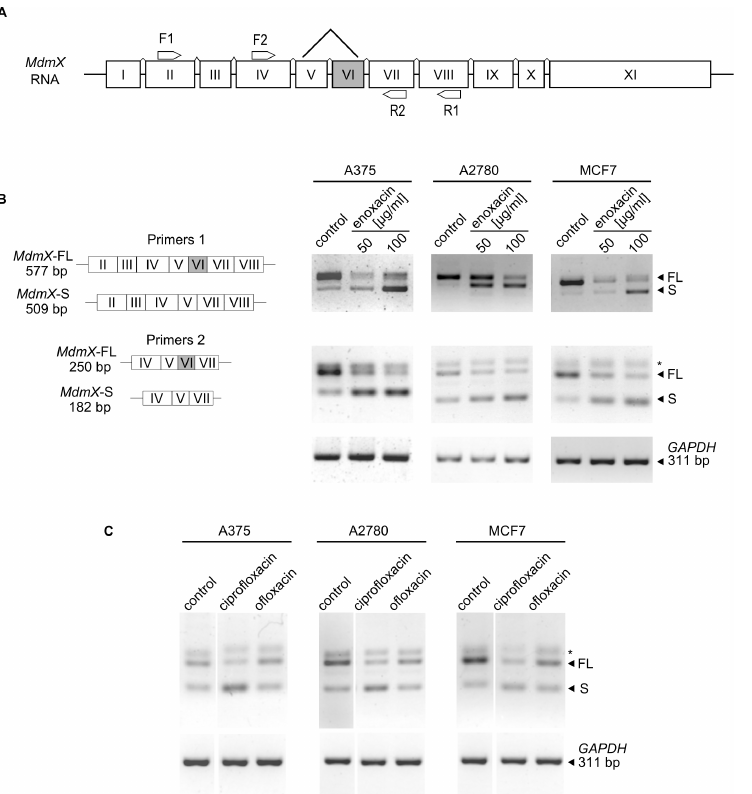
Fig 4. Enoxacin promotes MdmX exon 6 skipping in melanoma and non-melanoma cancers overexpressing MdmX. ( A ) Schematic representation of MdmX mRNA exon structure and bindingsites for PCR primers used in RT-PCR to determine the presence/absenceof exon 6 (VI). ( B, left ) Schematic representation of expected MdmX RT-PCR products in the case of presence ( MdmX-FL ) or absence ( MdmX-S ) of exon 6. ( B, right ) RT-PCR analysisof MdmX exon 6 skippingin A375, A2780, and MCF7 cells treated with enoxacin(50 and 100 μ g/ml) for 24 hours (primers 1 –top, primers 2 –middle, GAPDH PCR control–bottom). ( C ) RT-PCR analysisof MdmX exon 6 skippingin A375, A2780 and MCF7 cancer cell lines treated with ciprofloxacin and ofloxacin(both 100 μ g/ml) for 24 hours (MdmX primers 2 –top, GAPDH PCR control–bottom). * Non-specific